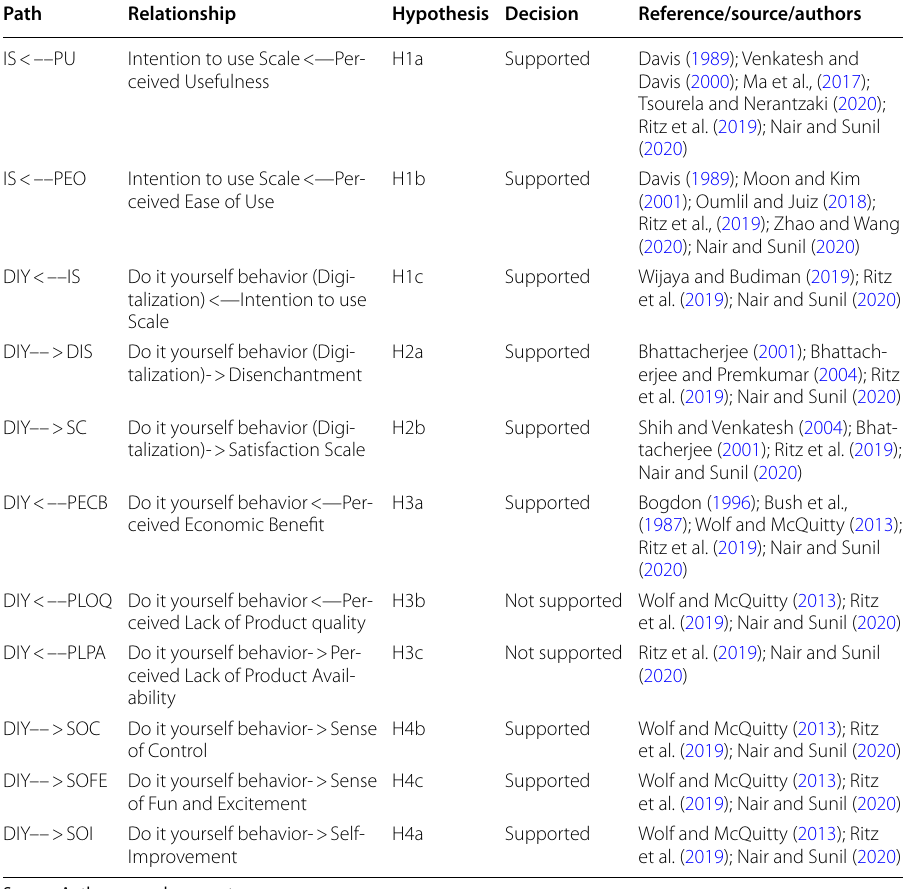
Table 5 Academic literature confirming the results of the current